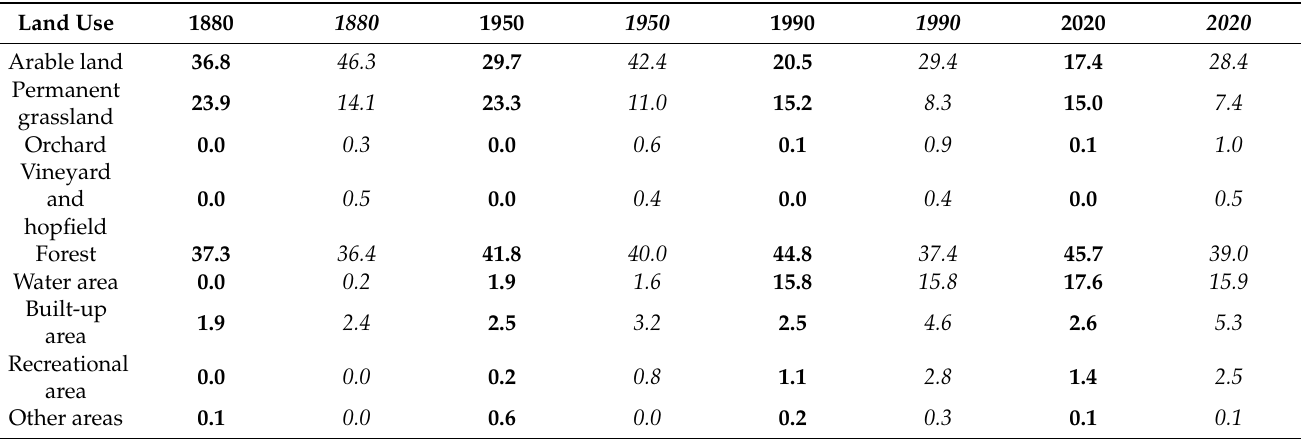
Table 4. The proportion of the land use categories in the drinking water reservoirs and other reservoirs with their surroundings in four periods (%).